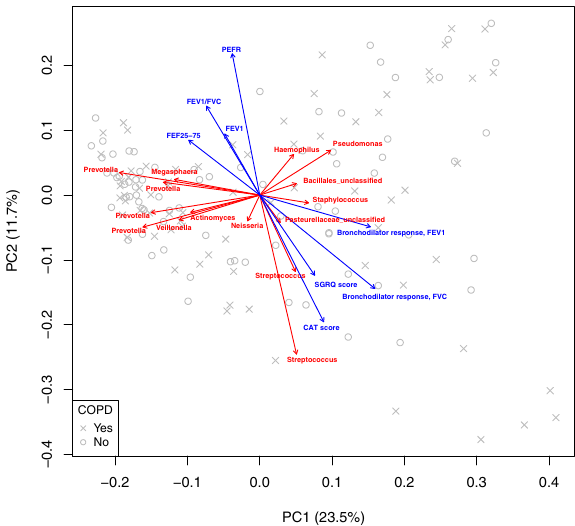
Fig. 2 Differential relationships between lung bacterial composi- tion, speci fi c lung function measures, and symptoms are main- tained among ever-smokers without or with mild-moderate COPD. Principal coordinate analysis (PCoA) of lung bacterial community variation (weighted Unifrac distance) among ever- smokers without (gray circles) or with (gray Xs) mild-moderate COPD and relationships to the clinical variables shown (blue arrows; R env fi t ). An overlaid biplot analysis shows the microbiota members (red arrows) driving the observed variation in lung bacterial community structure amongst these